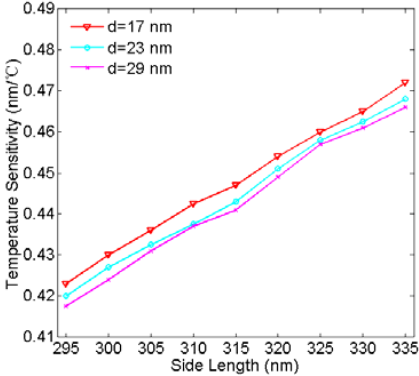
Figure 9. Temperature sensitivity versus side length for coupling distance d = 17 nm, 23 nm, and 29 nm, respectively.